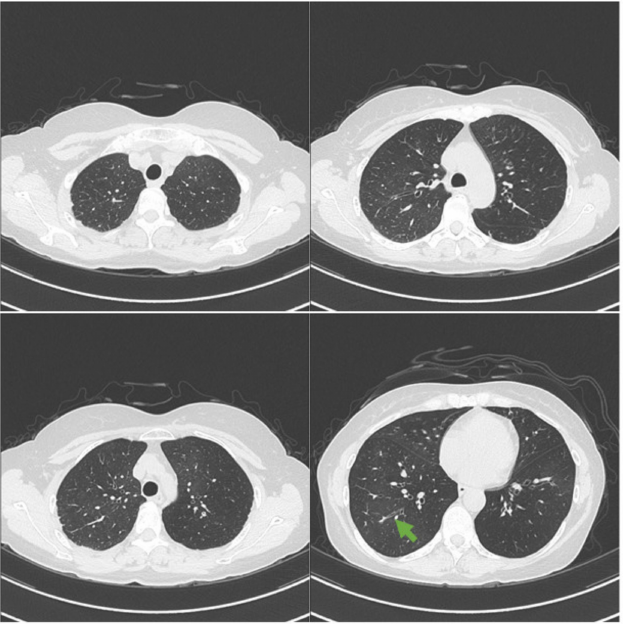
Figure 1. Computed tomography shows mosaic attenuation and multiple small centrilobular and branching nodules in both lungs. Bronchial wall thickening and lumen narrowing at the peripheral side were also seen (green